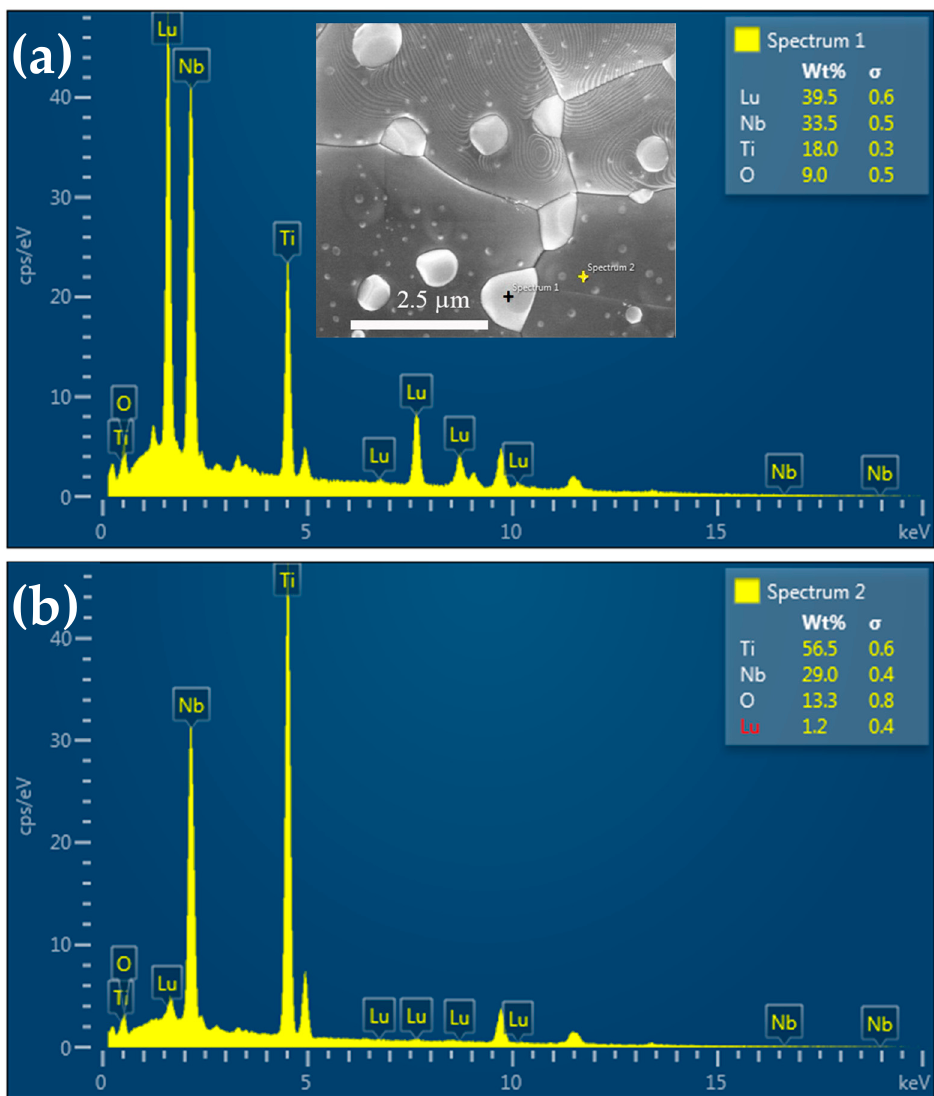
Figure 4. EDS spectra of LuNTO-2 ceramic detected at ( a ) the secondary phase particle and ( b ) regular grain; insets show the SEM images of the EDS testing points.